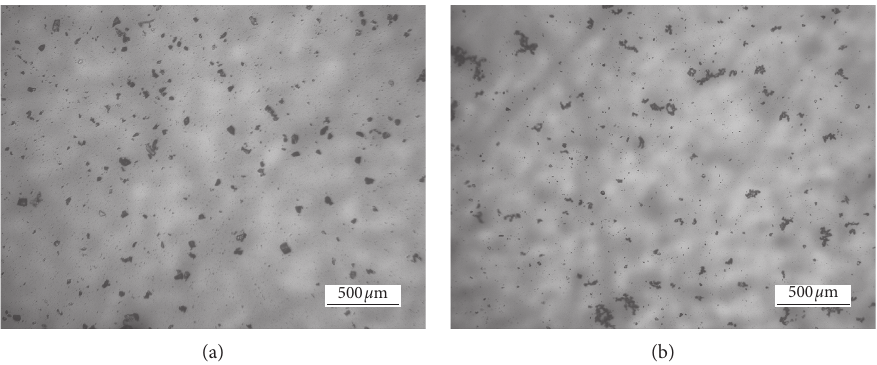
Figure 9: Scheelite and fluorite particles ( − 10 μ m) in ultrapure water: (a) pH 8; (b) pH